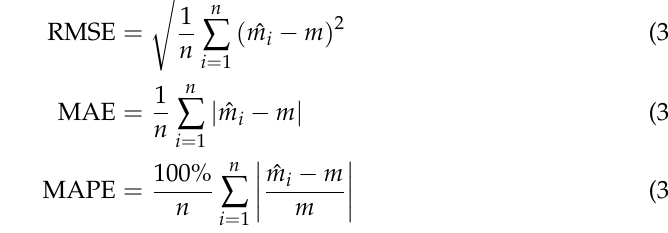
Slopes of simulation ::::: :: :::::::::